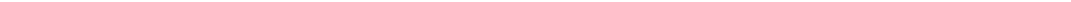
Figure 1: Actions of ARNI in the neurohormonal cascade. The angiotensin II receptor/neprilysin inhibitor valsartan/sacubitril combines tradi- tional neurohormonal inhibition targeting the renin-angiotensin-aldosterone system with an enhancement of the natriuretic peptide system through inhibition of natriuretic peptide degradation, thereby promoting their beneficial effects. ANP: atrial natriuretic peptide; BNP: brain (or B- type) natriuretic peptide; CNP: C-type natriuretic peptide; NPR: natriuretic peptide receptor; RAAS: renin-angiotensin-aldosterone system; Ang II: angiotensin II; AT1R: angiotensin II type 1 receptor; LV: left